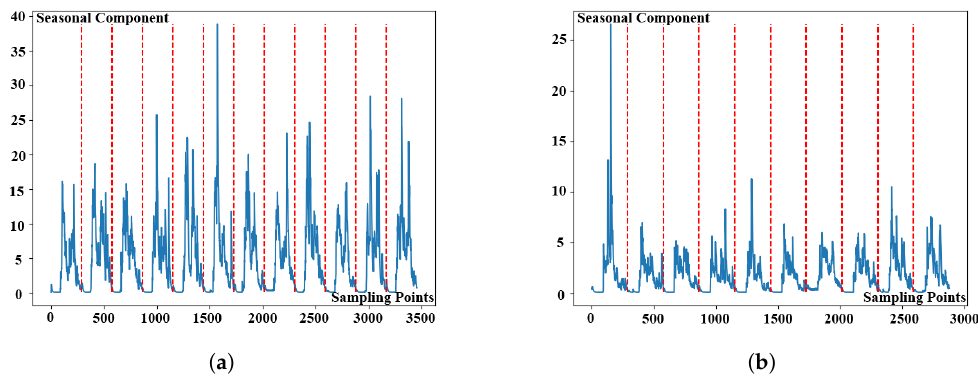
Figure 10. Mosaic of KPI time series data in different modes. ( a ) KPI time series data in working day mode. ( b ) KPI time series data in rest day